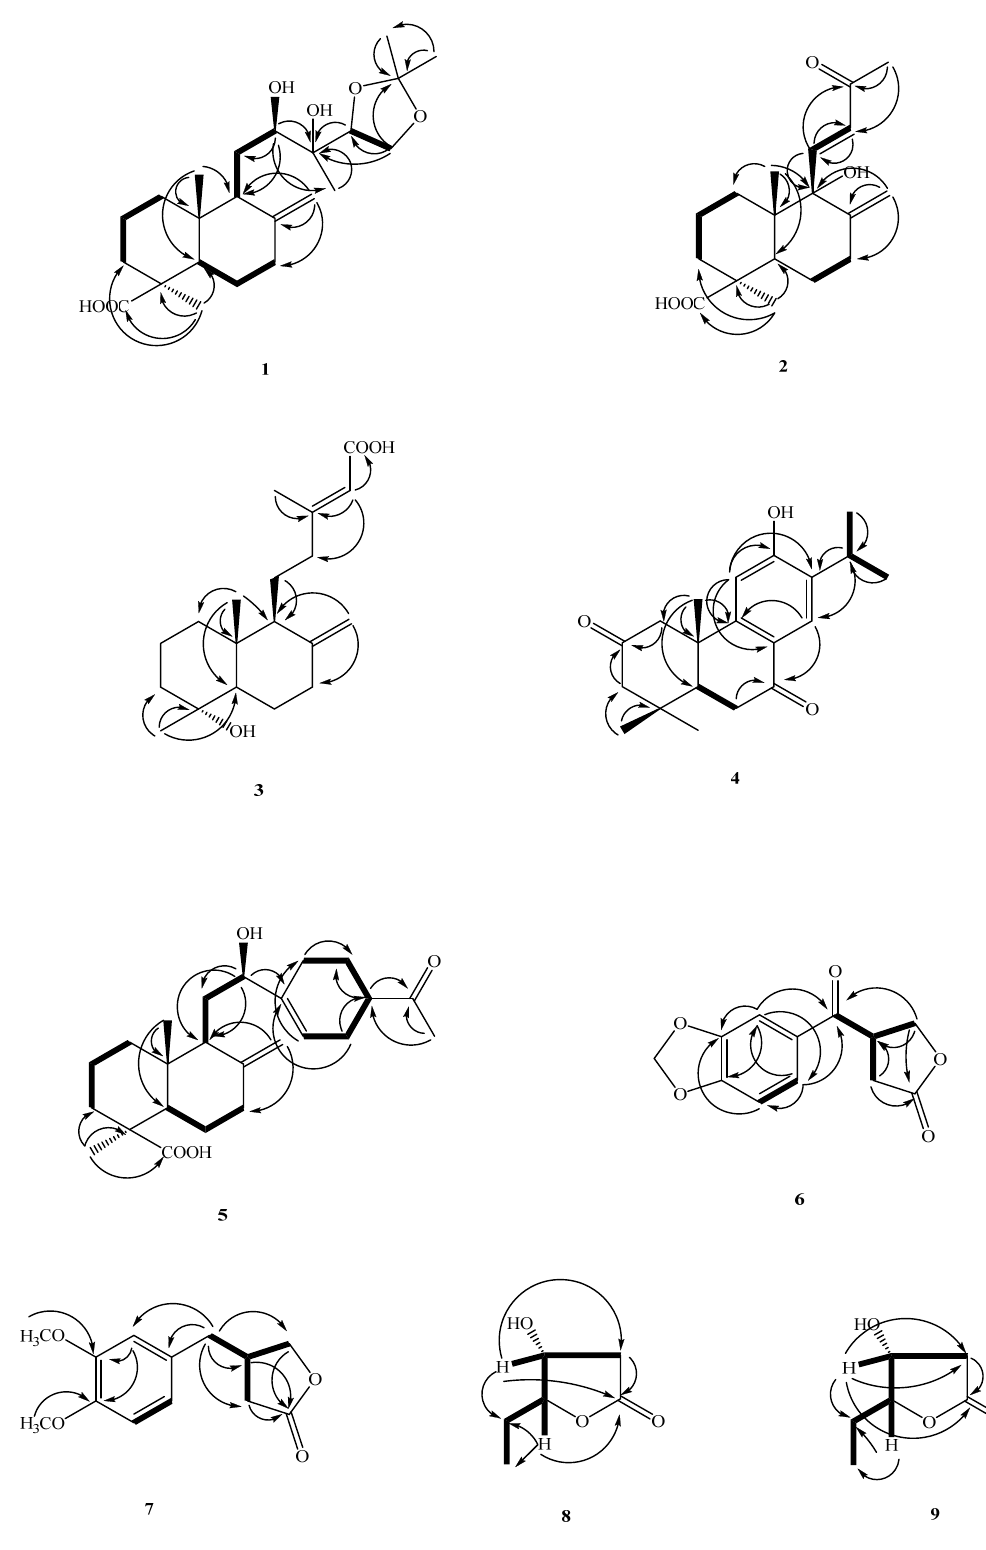
Figure 3. Key COSY ( ▬ ) and HMBC ( → ) correlations of 1 ‒ 9 . Compound 4 was isolated as colorless oil with [ α ] 25D : +60.6 ( c 0.011, MeOH). The HR- EI-MS data determined the molecular formula to be C 20 H 26 O 3 ( m / z 314.1884 ([M] + ; calc. 314.1882)). The UV absorption of 4 at 280 nm suggested the presence of a benzenoid